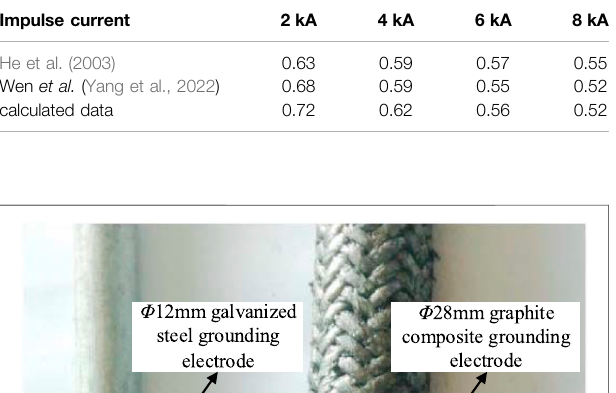
TABLE 2 | Material parameters of the steel and graphite grounding electrode.